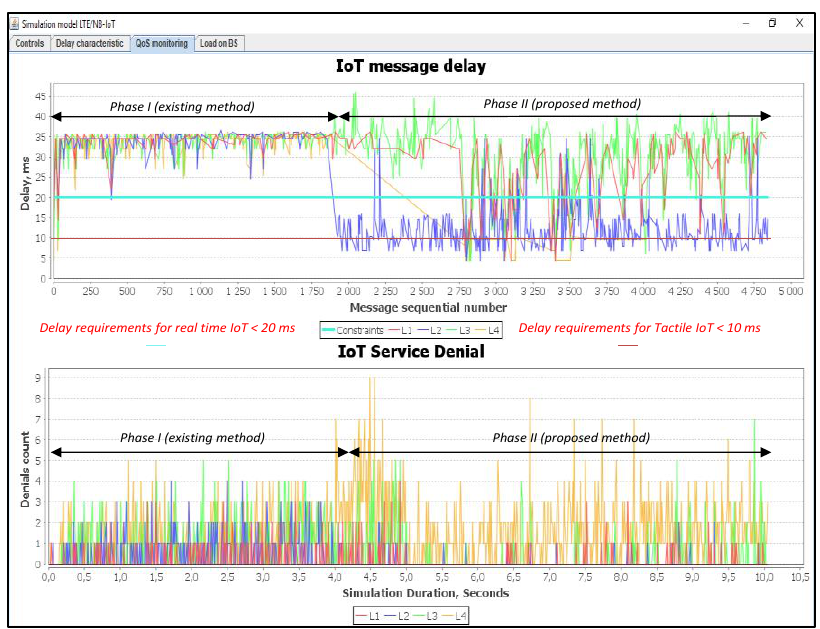
Figure 23. Current delay and service denials count when servicing requests from IoT devices (average load of IoT controller ρ = 100%).